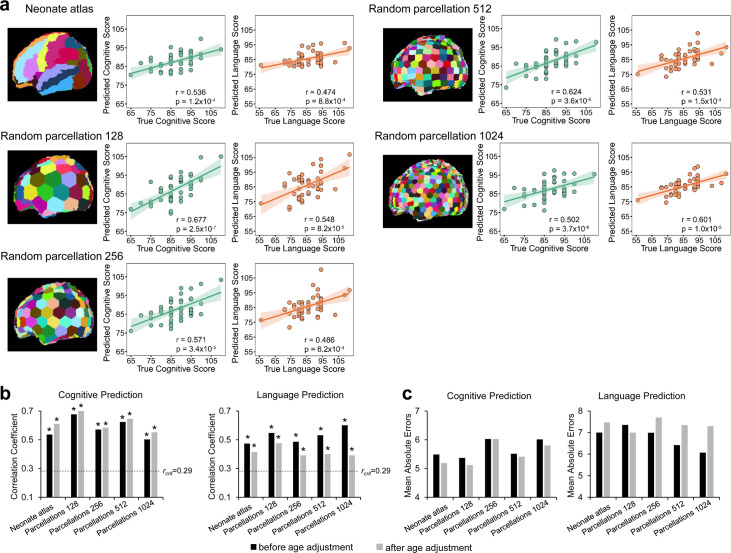
Evaluation of robustness of prediction models with different cortical region-of-interest (ROI) schemes and age adjustments.(a) Various cortical ROI schemes, including 52 cortical regions from the neonate atlas labeling, 128, 256, 512, and 1024 randomly parcellated cortical regions with equal size, were tested by using cortical fractional anisotropy (FA) measured at these ROIs as features in prediction models. The scatter plots show the linear regressions between actual scores and the predicted cognitive or language scores based on the cortical FA measures obtained with various ROI schemes. (b) Significant correlations between the predicted and actual cognitive and language scores were found for all ROI schemes before age adjustment and all ROI schemes after age adjustments. Dashed lines indicate critical r value corresponding to p=0.05. * in the panel indicates significant (p<0.05) correlation. (c) Mean absolute error with all ROI schemes and age adjustment are shown.